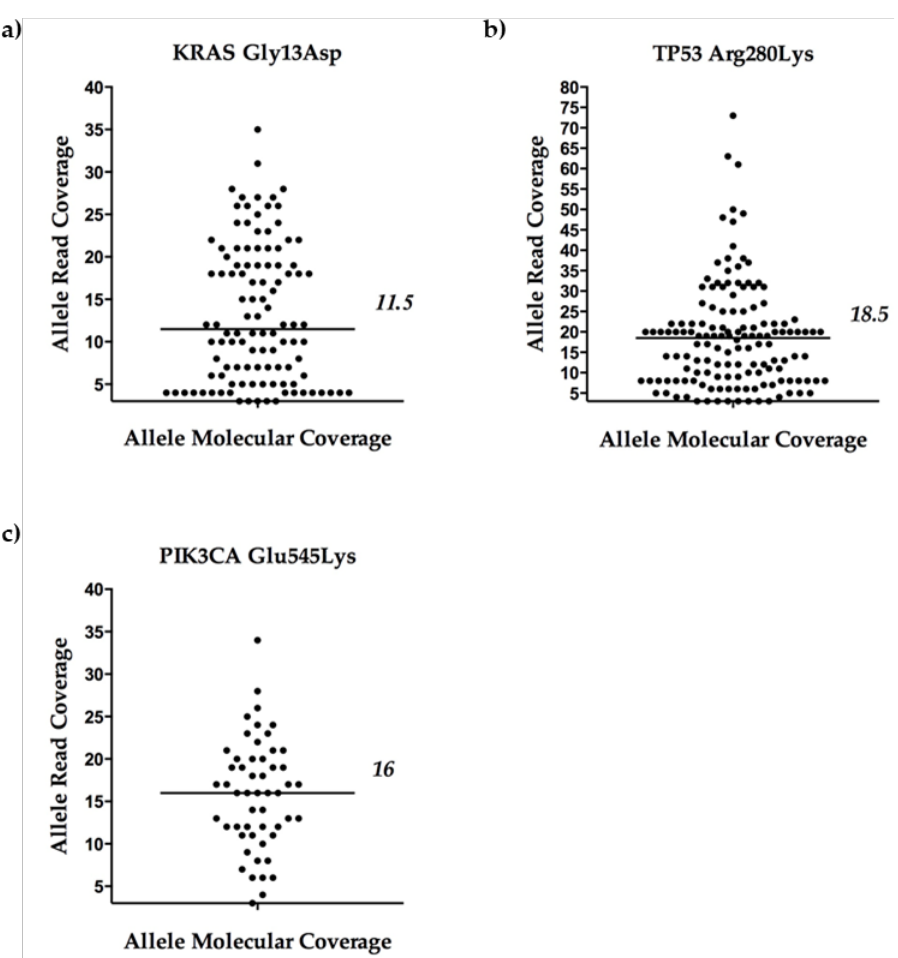
Figure 3. Coverage metrics of KRAS Gly13Asp, TP53 Arg280Lys, and PIK3CA Glu545Lys variants. Scatter dot plots in ( a , b ) show the Allele Read Coverage and the Allele Molecular Coverage for KRAS Gly13Asp and TP53 Arg280Lys, respectively, as found in MDA pools, and in ( c ) for PIK3CA Glu545Lys in MCF-7. Each dot represents a single molecular DNA molecule on the x -axis (i.e., Allele Molecular Coverage) and the corresponding number of reads on the y -axis (i.e., Allele Read Coverage). The origin of the axes was set to 3, corresponding to the default minimum value of reads to enable a variant calling.